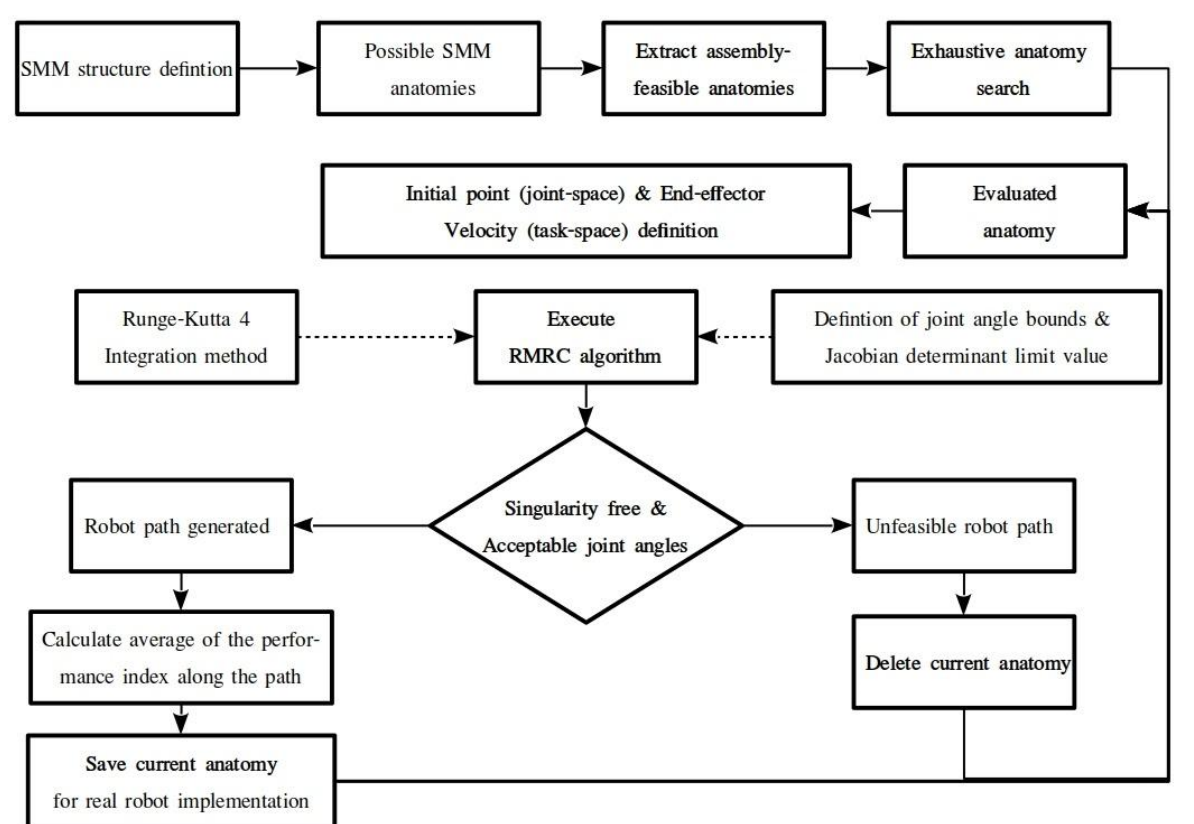
Figure 5. Database generation of trajectories for feasible anatomies of a SMM.